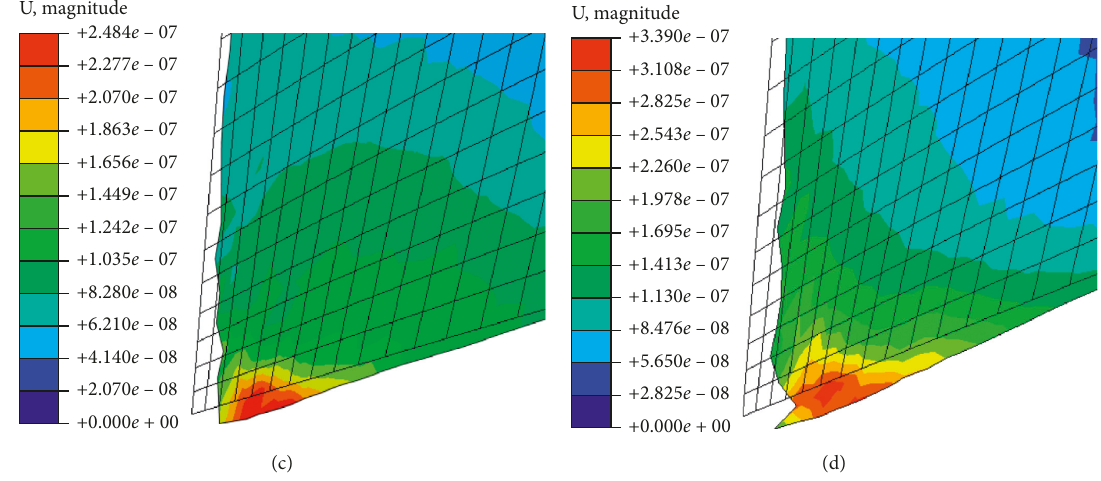
Figure 15: The amplified deformation of the tool under different tool back angles ( H 20 ° . (c) α 15 ° ; (d) α (cid:31) (cid:31)